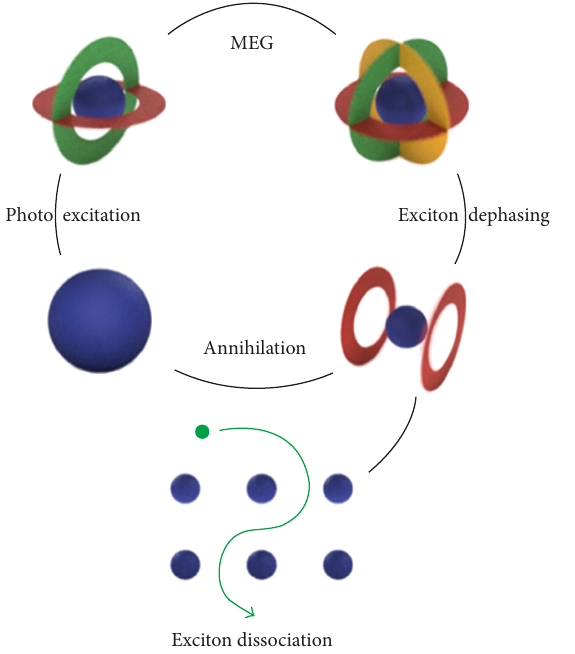
Figure 2: Multiple exciton generation in a photovoltaic device, adapted from [5].